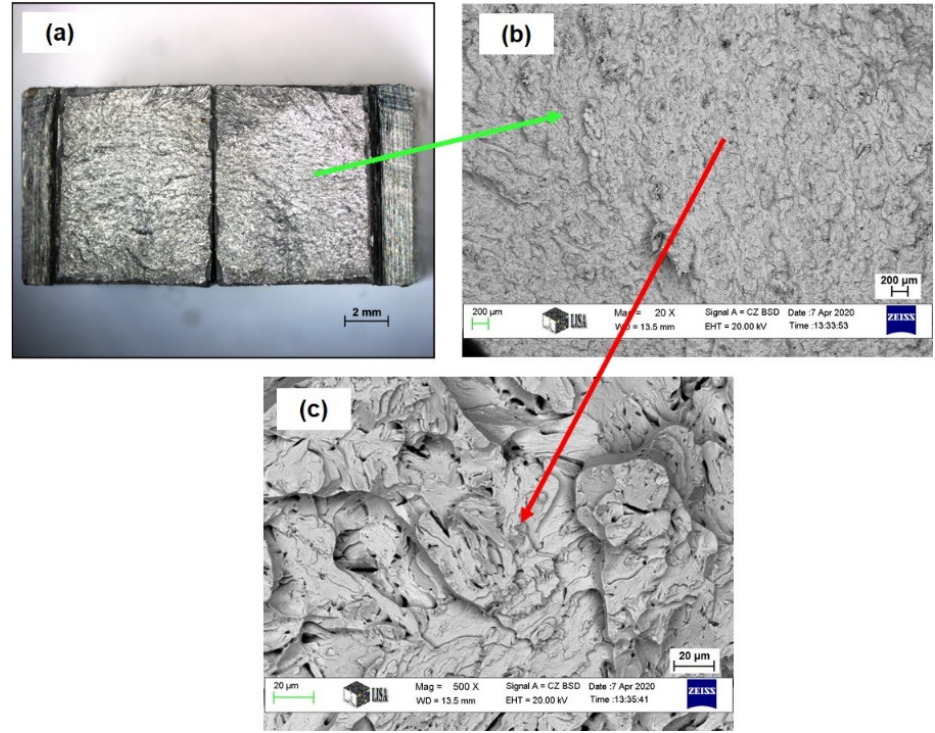
Figure 13. ( a ). FZ Charpy V specimen at a test temperature of − 40 °C; ( b ) SEM photo of full-fractured surface; ( c ) fractograph.